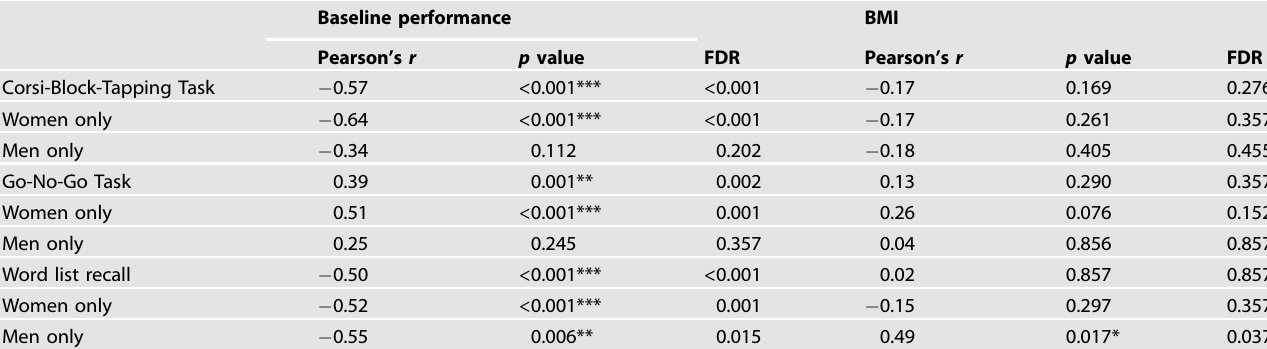
Table 1. Relationship between glucose-induced bene fi t and baseline